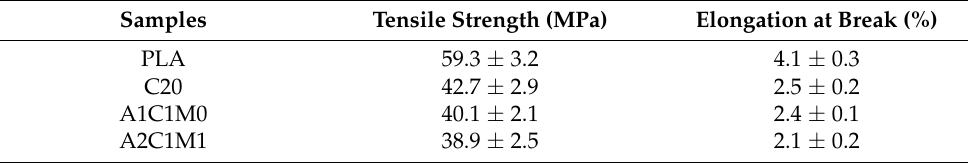
Table 4. Mechanical properties of PLA and flame-retardant PLA composites.